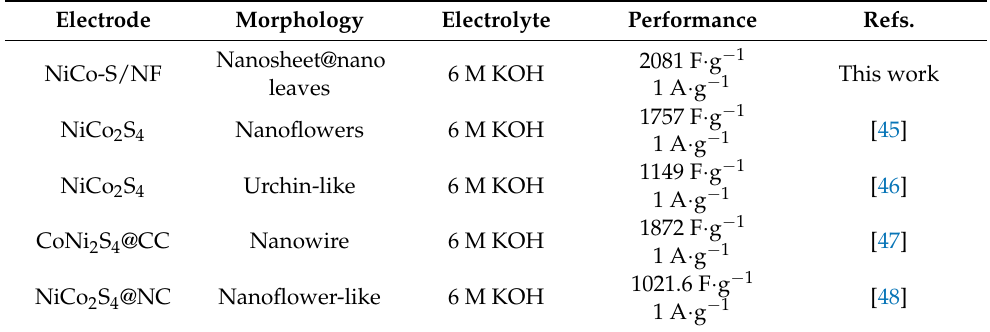
Figure 7. ( a ) GCD curves at 1 A · g − 1 of different electrodes. ( b ) GCD curves at different current densities of the NiCo-S electrode. ( c ) Variation in specific capacitance of all electrodes with different current densities. ( d ) EIS of all electrodes. Table 1. The properties of NiCo-S/NF are compared with those reported in other studies in the